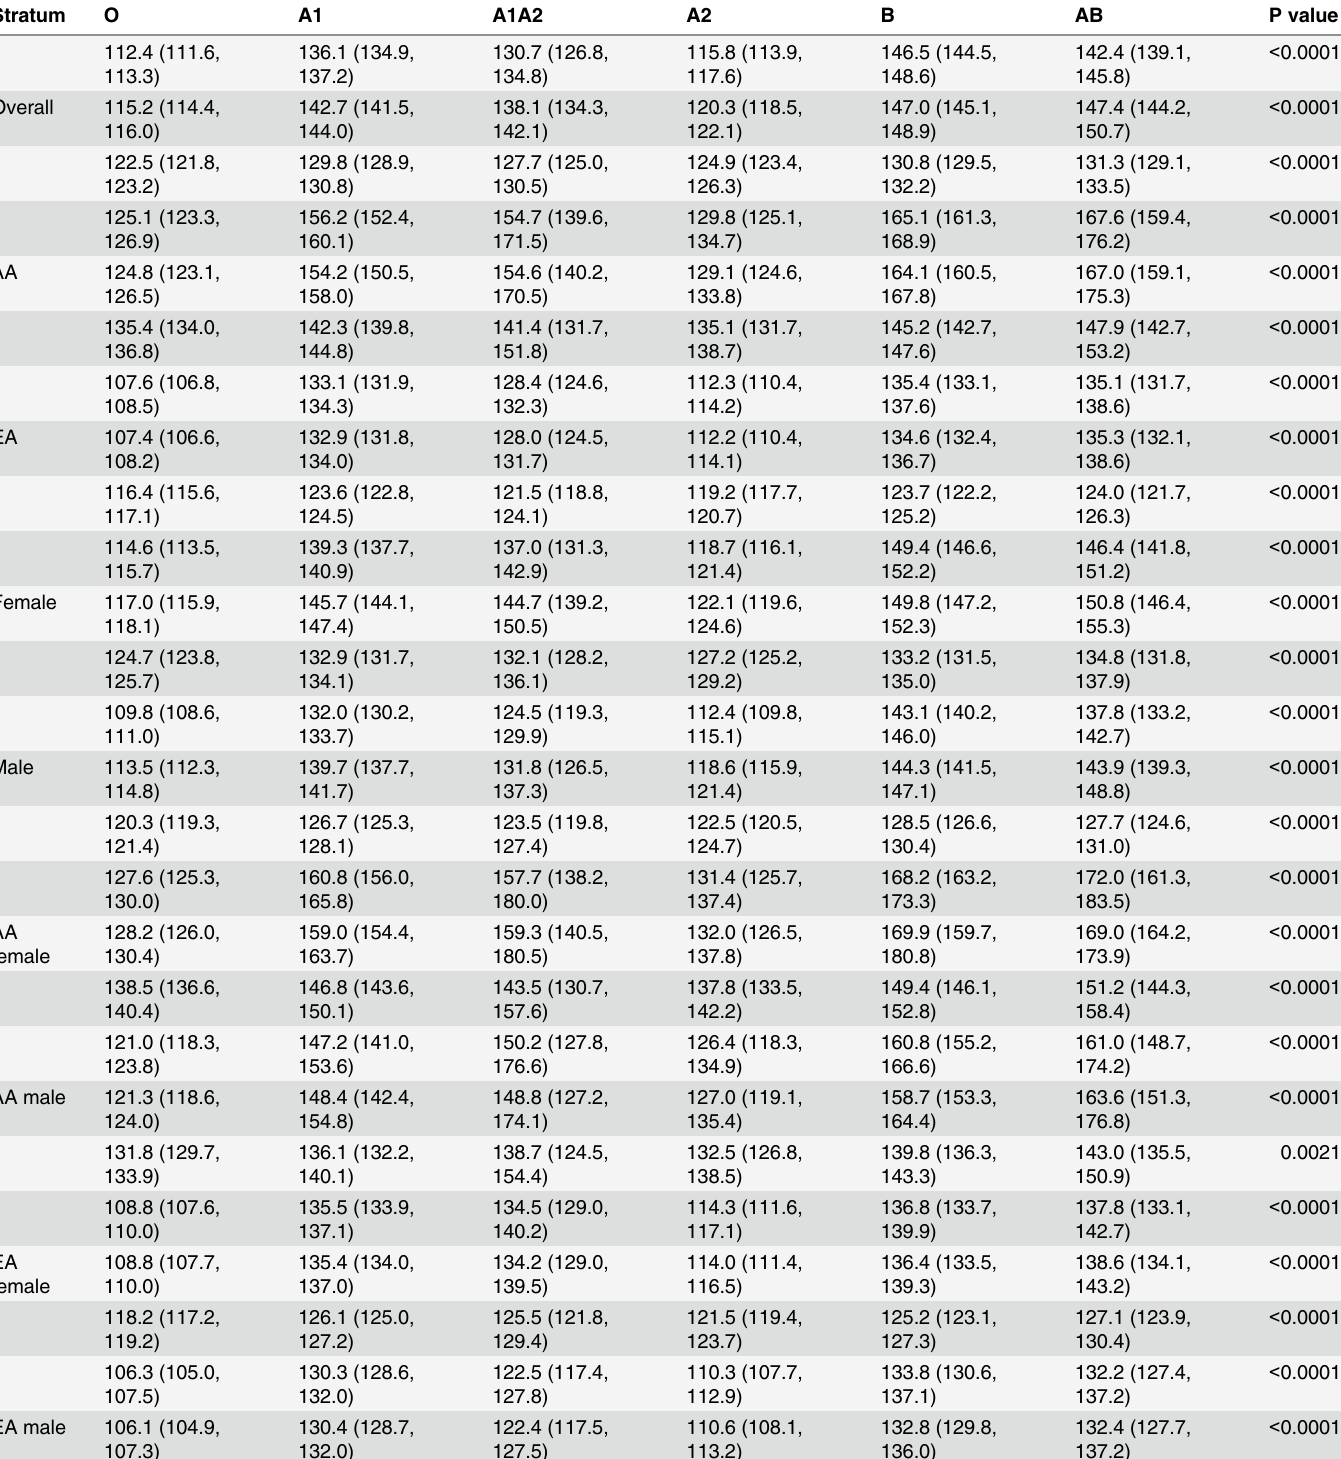
Table 3. Geometric Mean (95% CI) of FVIII Activity (%) in ABO Blood Groups * .